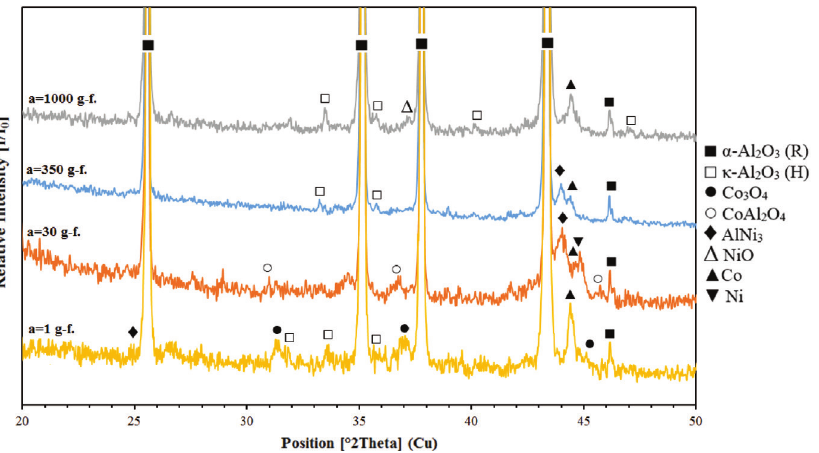
Fig. 8: The comparative XRD results of slags obtained for estimated composition of 5Al-20Co-75Ni mass% under high artificial gravity conditions